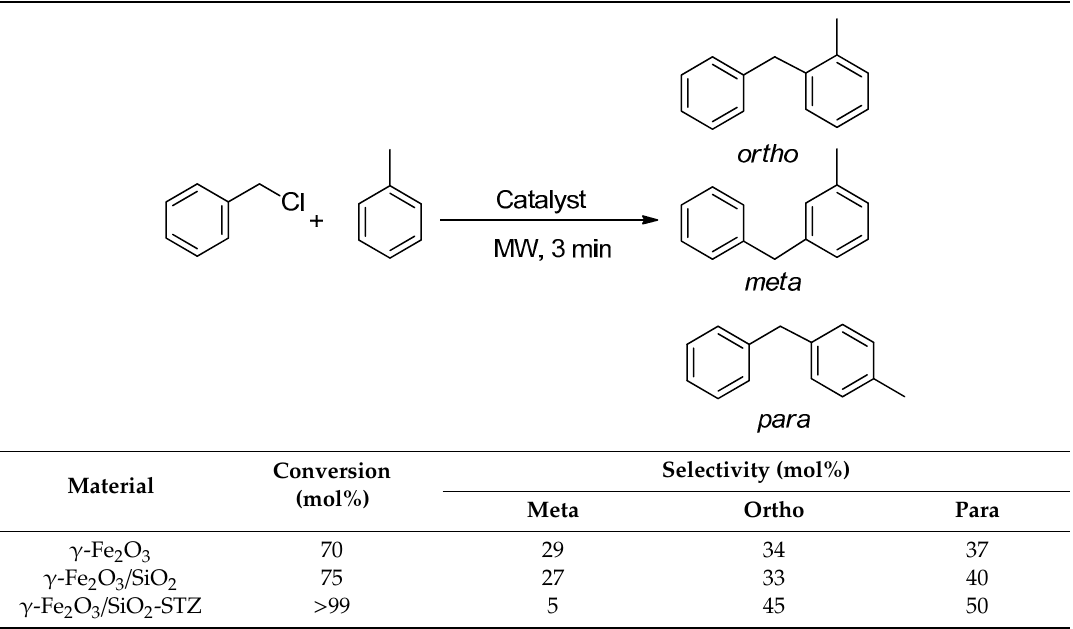
Table 4. Catalytic activity of γ -Fe 2 O 3 / SiO 2 -STZ in the microwave assisted alkylation of toluene with benzyl